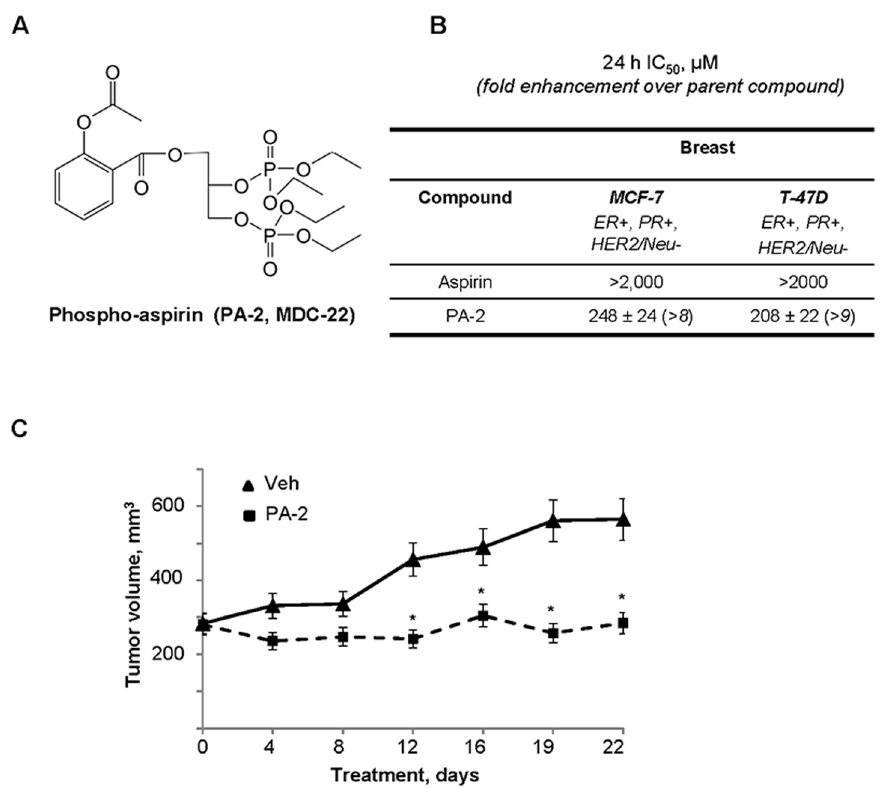
Figure 1. Phospho-aspirin-2 inhibits the growth of ER + breast cancer cells. A: Chemical structure of phospho-aspirin-2 (PA-2, MDC-22). B: 24 h-IC 50 values of PA-2 and aspirin in ER + breast cancer cell lines. C: Chemotherapeutic effect of PA-2 on subcutaneous MCF7 xenografts in nude mice. Nude mice bearing established MCF7 xenografts were treated with vehicle or PA-2 (500 mg/kg in corn oil) for five times a week. *, p , 0.01, compared to control; n =16 tumors/group.